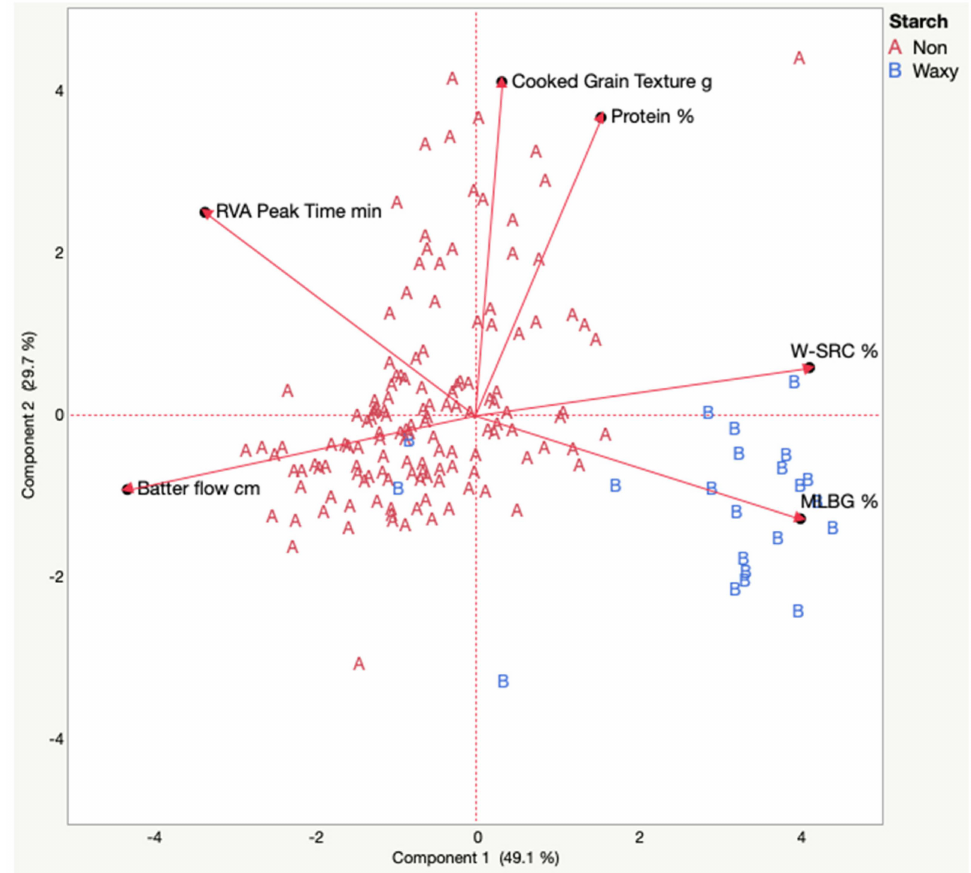
Figure 1. Mean-centered and scaled principal component biplot of 6 selected naked barley traits. A = non-waxy genotypes. B = waxy genotypes. MLBG = mixed linkage beta glucan. W-SRC = water solvent retention